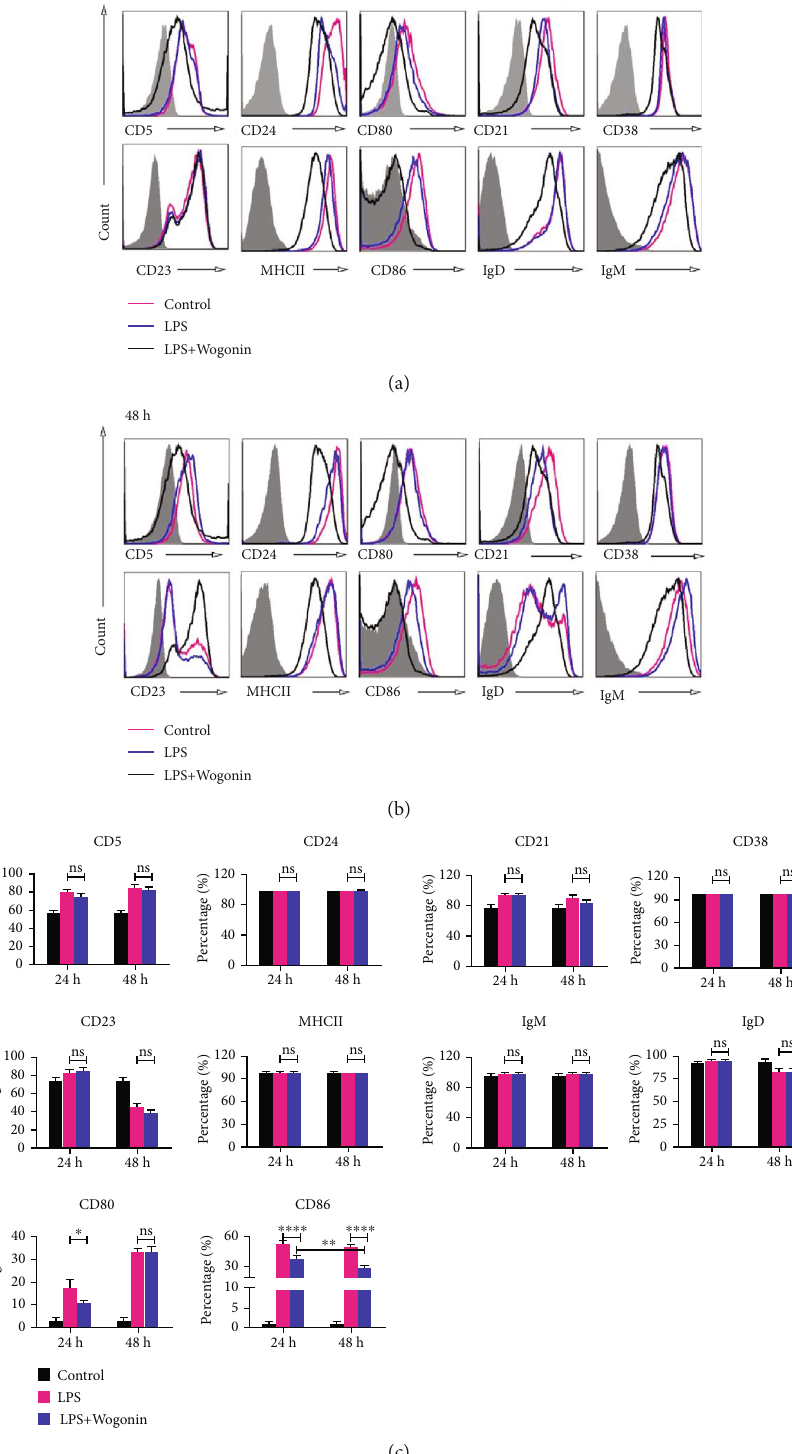
Figure 3: E ff ect of Wogonin on the surface molecules of B cells. CD19 + cells were cultured with LPS in the presence of 12.5 μ M Wogonin for 24h and 48 h to analyze the surface marker levels. (a, b) The expression levels of CD5, CD24, CD21, CD38, CD23, MHCII, IgM, IgD, CD80, and CD86 in untreated B cells (black), LPS-treated B cells (red), and LPS+Wogonin-treated B cells (blue) were measured by FACS, respectively. (c) Quanti fi cation of B cell surface molecules. Data are expressed as mean ± SD of three independent experiments. ∗ P < 0 : 05 ; ∗∗ P < 0 : 01 ; ∗∗∗∗ P < 0 : 0001 ; ns: no signi fi